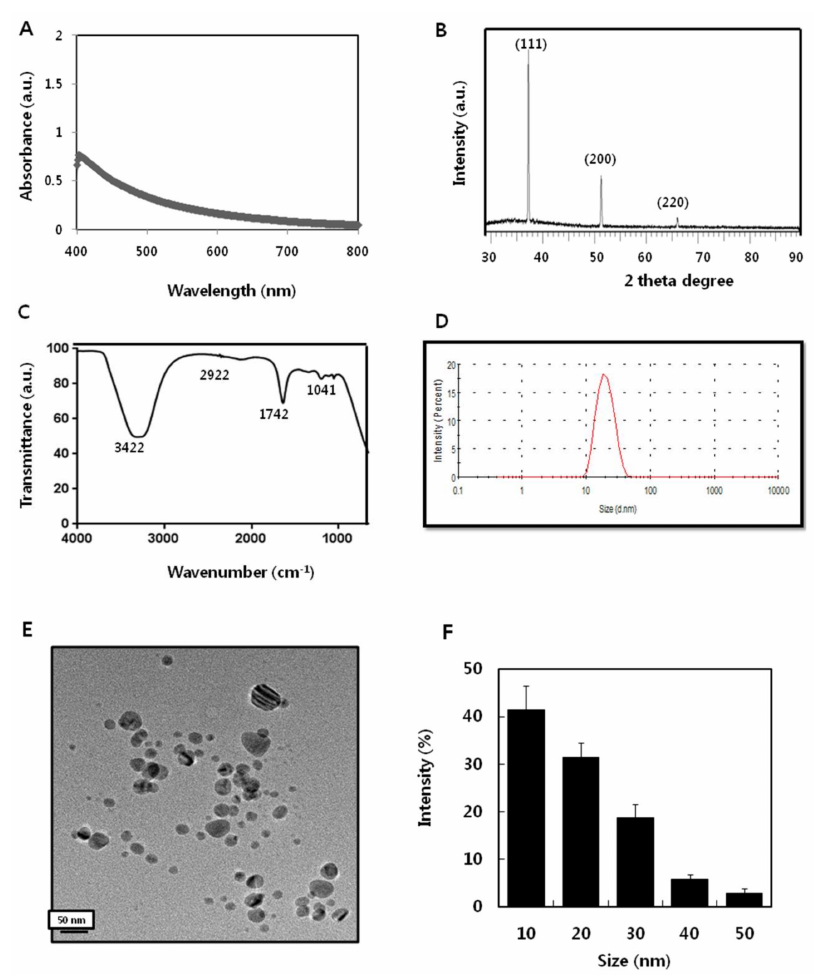
Figure 2. Synthesis and characterization of silver nanoparticles (AgNPs) using